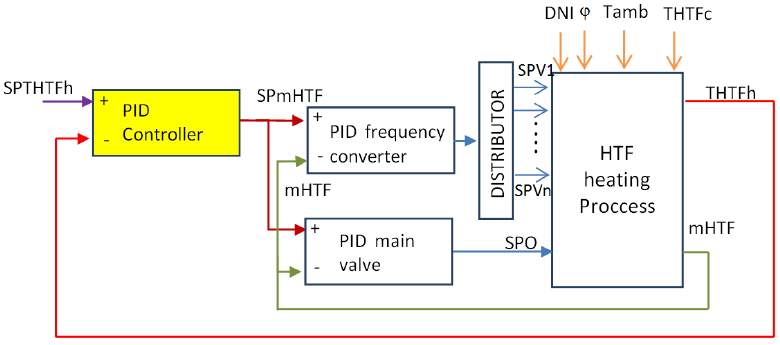
Figure 16. Proportional ‐ integral ‐ derivative (PID) automatic control of the HTF ‐ heating process.